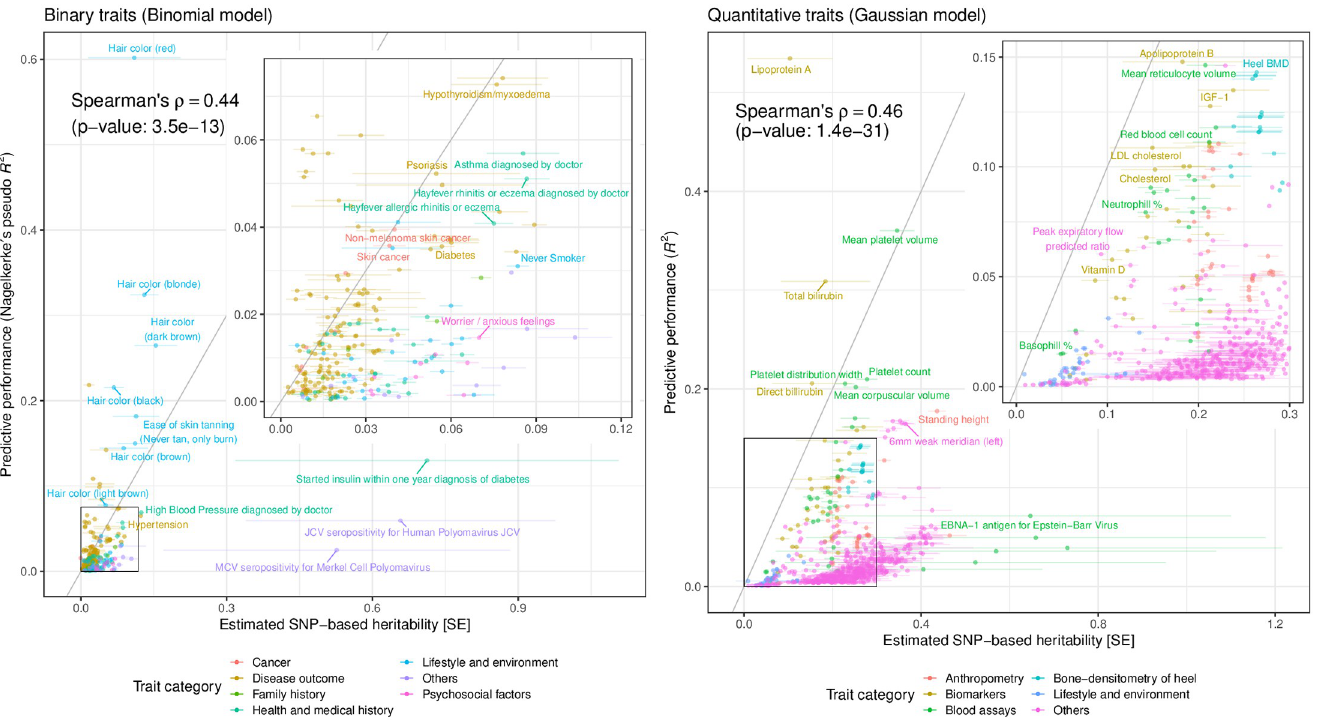
Fig 2. Comparison of the estimated SNP-based heritability and predictive performance across the 813 traits with significant PRSs. The predictive performance (Nagelkerke’s pseudo- R 2 for 244 binary traits [left] and R 2 for 569 quantitative traits [right]) of the PRS models that only consider genetic variants are compared against the estimated SNP-based heritability. Both metrics are shown in observed scale and depend on the proportion of cases in the target and discovery cohorts. The solid gray lines represent y = x. We show the points on the bottom left corners in the inset plots. The error bars represent standard error. BMD: Bone mineral density.